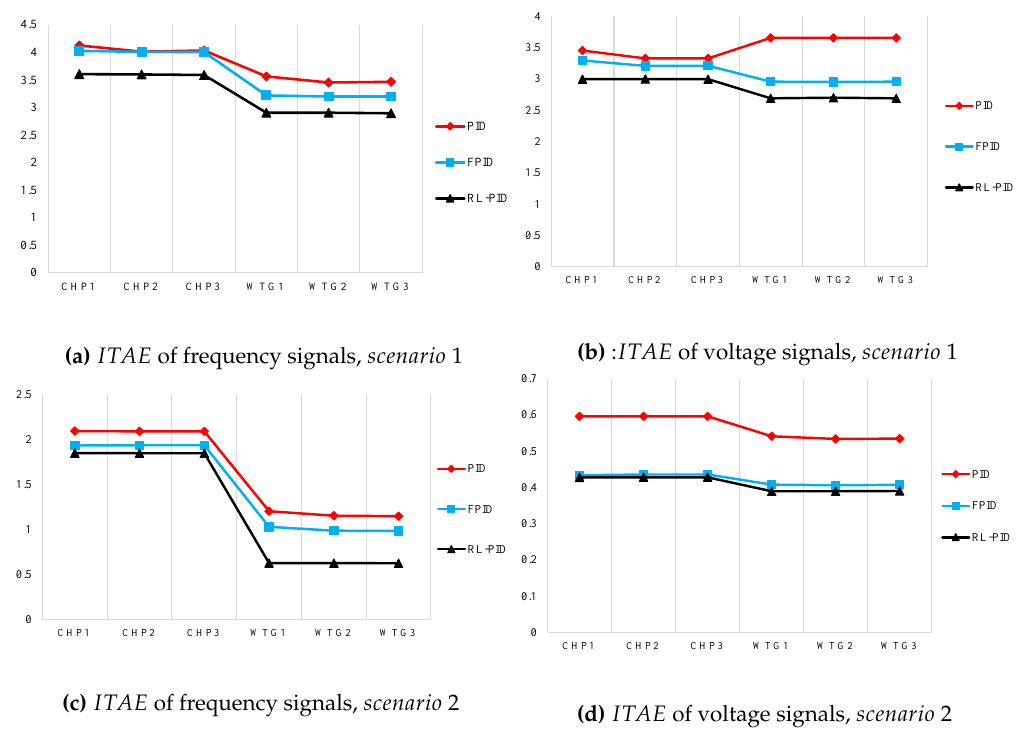
Figure 21. The presentation of the time domain performance indices in various